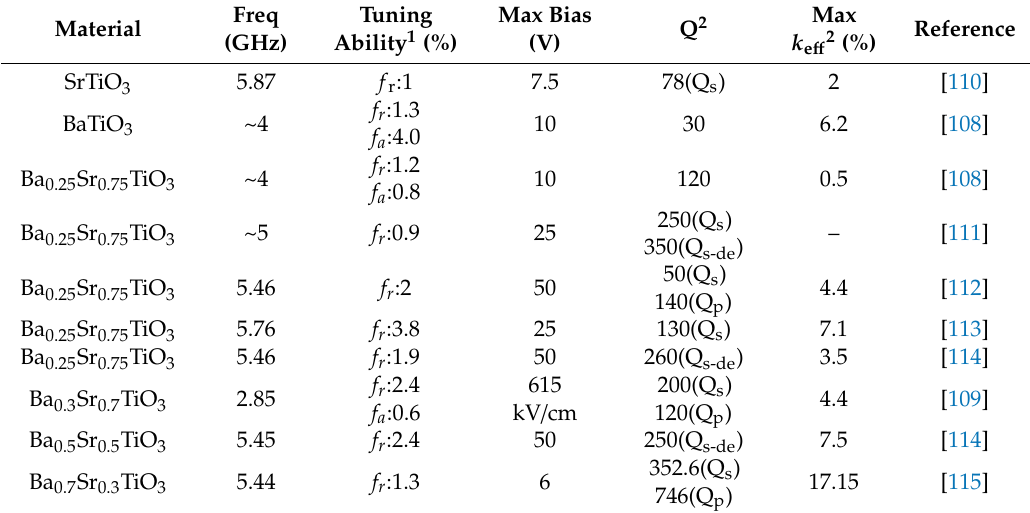
Table 4. Performance of reported BAW resonators based on tunable